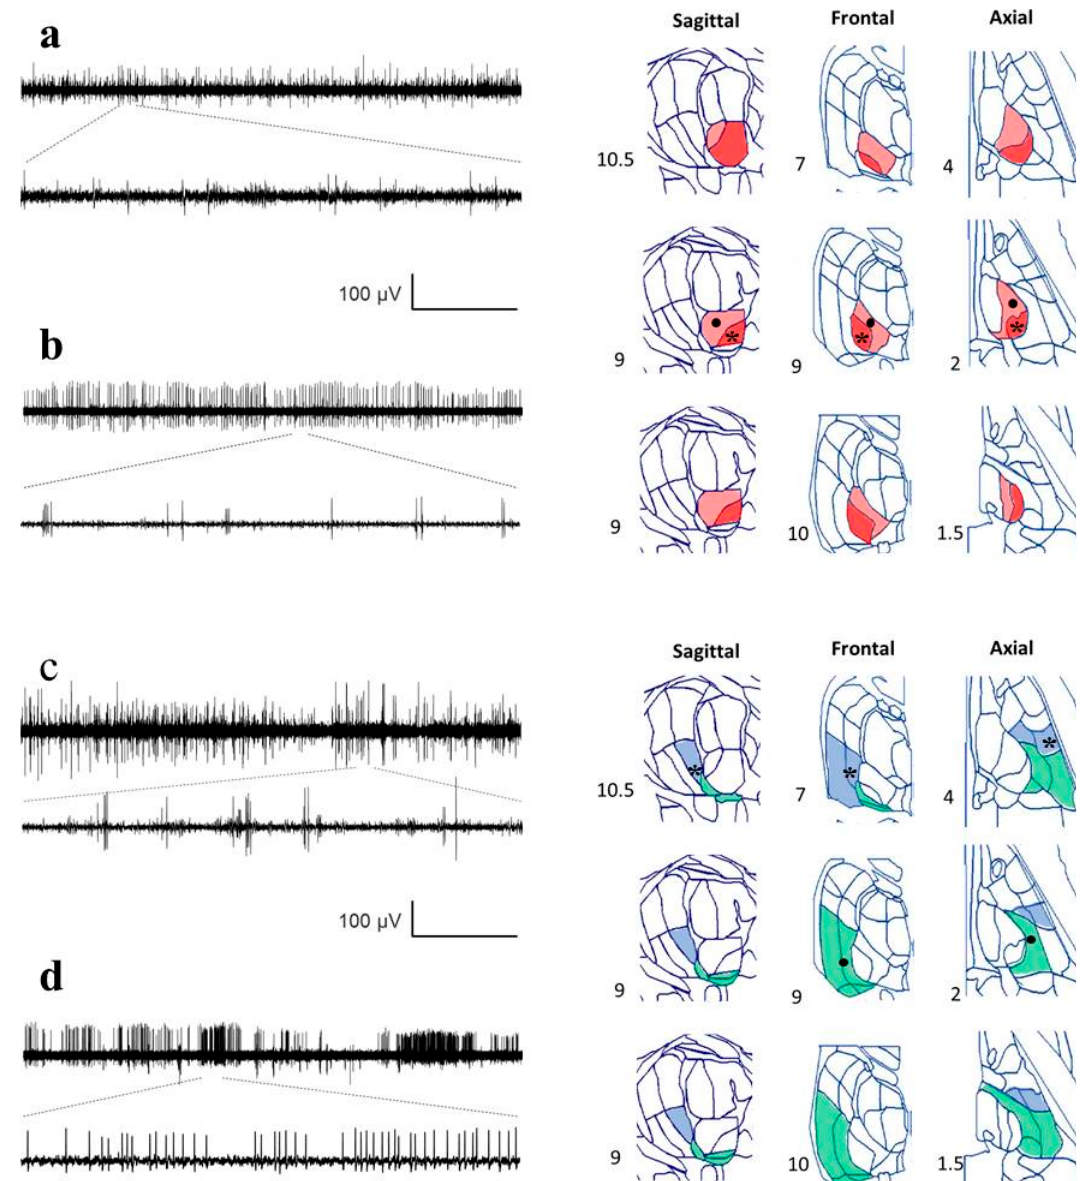
Figure A2. Recordings from different nuclei and positions identified by reconstruction. Raw traces from MER are in the left column, and different planes from the Schaltenbrand–Wahren (SW) atlas are in the right column. Horizontal calibration bar: 5 s for the upper traces and 167 ms for the lower traces. ( a ) Ce.mc (pale red), asterisk indicates the location of the recording, ( b ) Ce.pc. (strong red), the dot shows the location of the recording, ( c ) V.im (blue), asterisk indicates the location of the recording, and ( d ) V.c (green), indicated by a dot. Numbers show the distance for every axis from the mid-intercommissural AC-PC line.